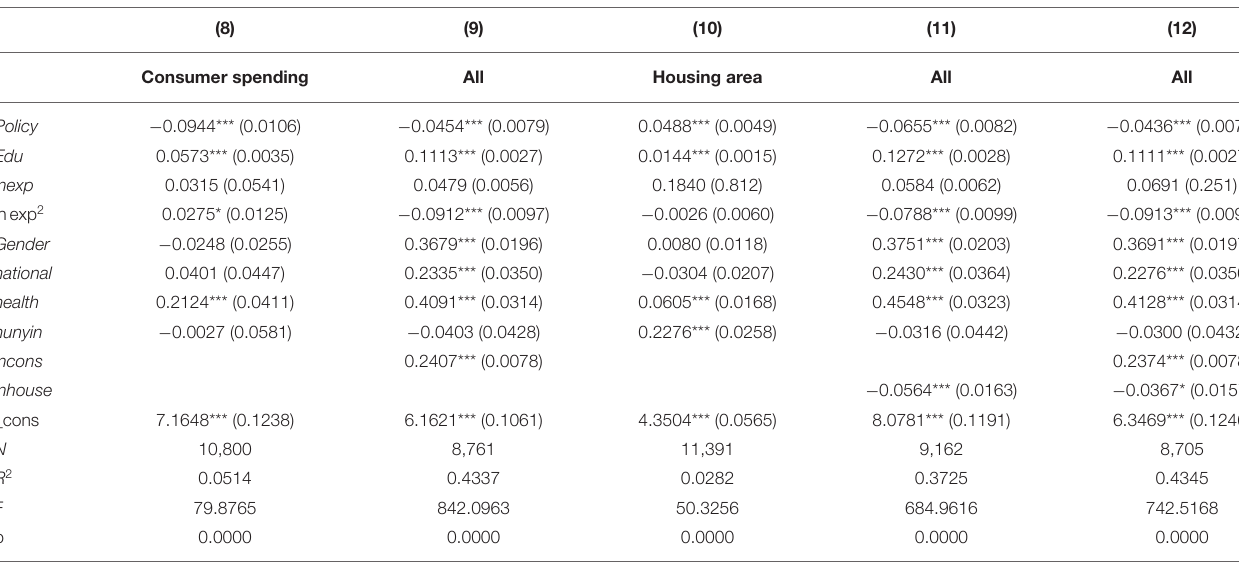
TABLE 5 | Regression results of mediating